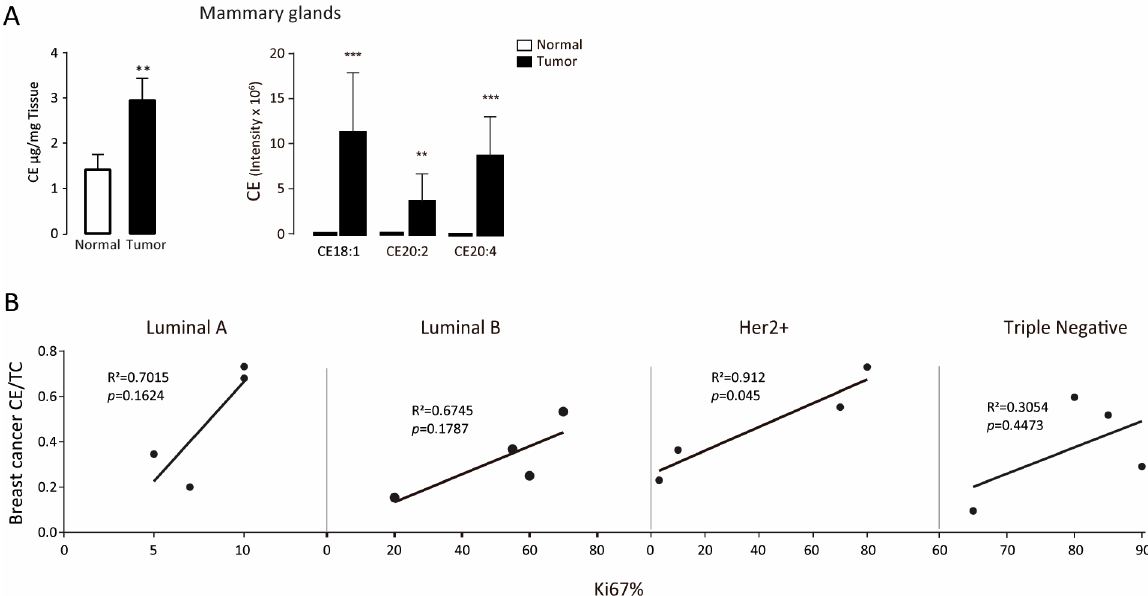
Figure 1. Cholesteryl ester level is elevated in tumor tissues. ( A ) Cholesteryl ester levels in mammary glands isolated from wild-type (WT) and PyMT mice. Error bars represent standard error of the mean (SEM). ** p < 0.01, *** p < 0.001, as deter- mined using a two-tailed Student’s t -test. ( B ) Correlation between intratumoral CE and Ki-67 positive population in dif- ferent breast carcinoma subtypes. The correlation was statistically significant ( p < 0.05) in Her2+ subtype but not in Luminal A, Luminal B, and Triple Negative subtypes.